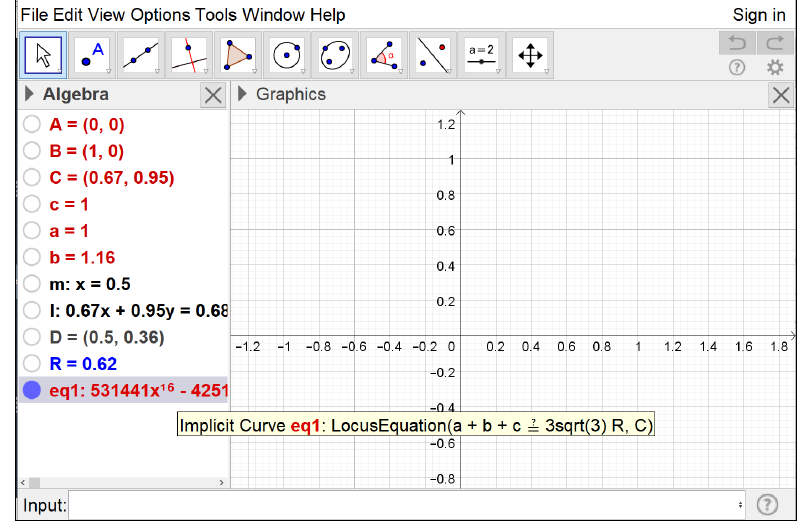
Figure 12. The algebraic curve P ( x , y ) = 0 does not appear